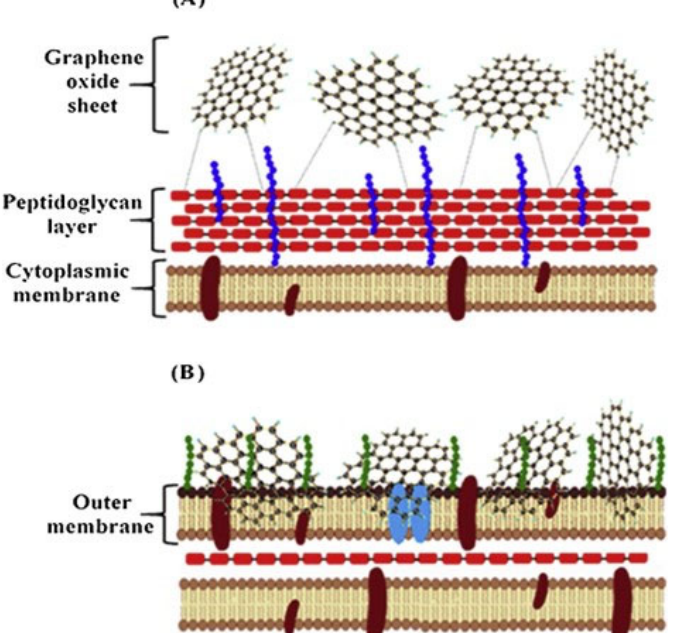
Figure 4. Design of the possible mechanism of GO interactions with Gram ‐ positive and Gram ‐ neg ‐ ative bacteria. ( A ) Mechanical wrapping in Gram ‐ positive bacteria and ( B ) the damage of the mem ‐ negative bacteria. ( A ) Mechanical wrapping in Gram-positive bacteria and ( B ) the damage of the brane in Gram ‐ negative bacteria. Reprinted with permission from ref. [102]. membrane in Gram-negative bacteria. Reprinted with permission from ref.